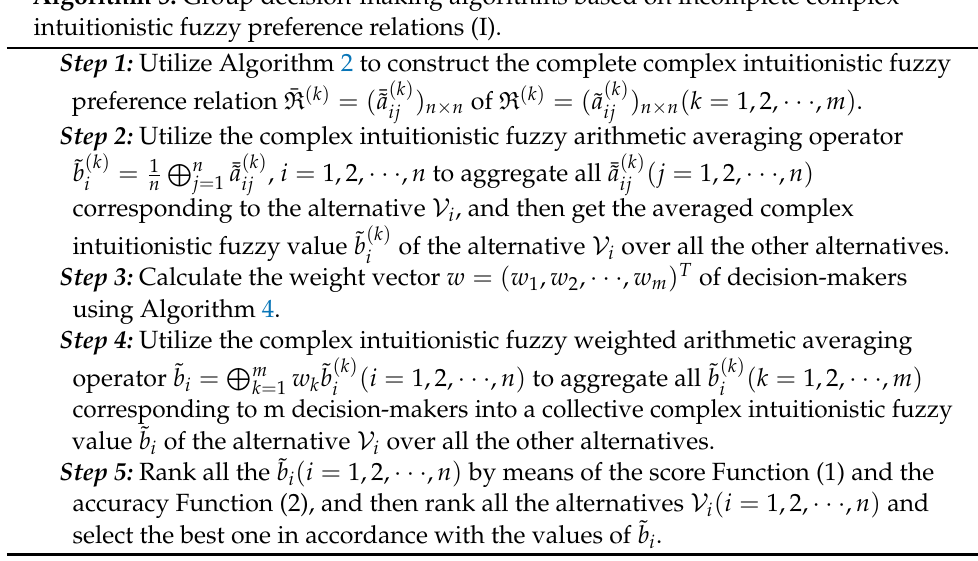
Algorithm 5: Group decision-making algorithms based on incomplete complex intuitionistic fuzzy preference relations